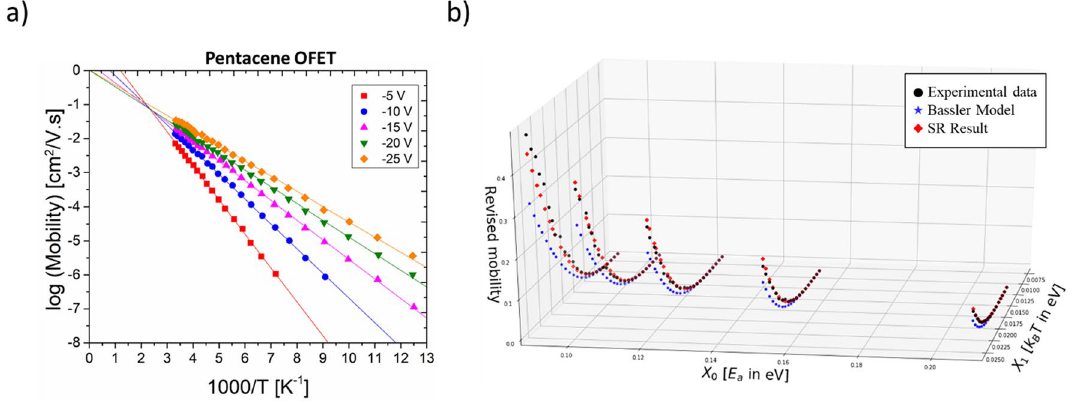
Figure 2. ( a ) Temperature-dependent mobility data for pentacene OFET; ( b ) Simultaneous visualization of the fits obtained from symbolic regression (SR) (red symbol) and the Bassler model (blue symbol) with respect to the experimental data (black symbol) (data extracted from Ref. 19